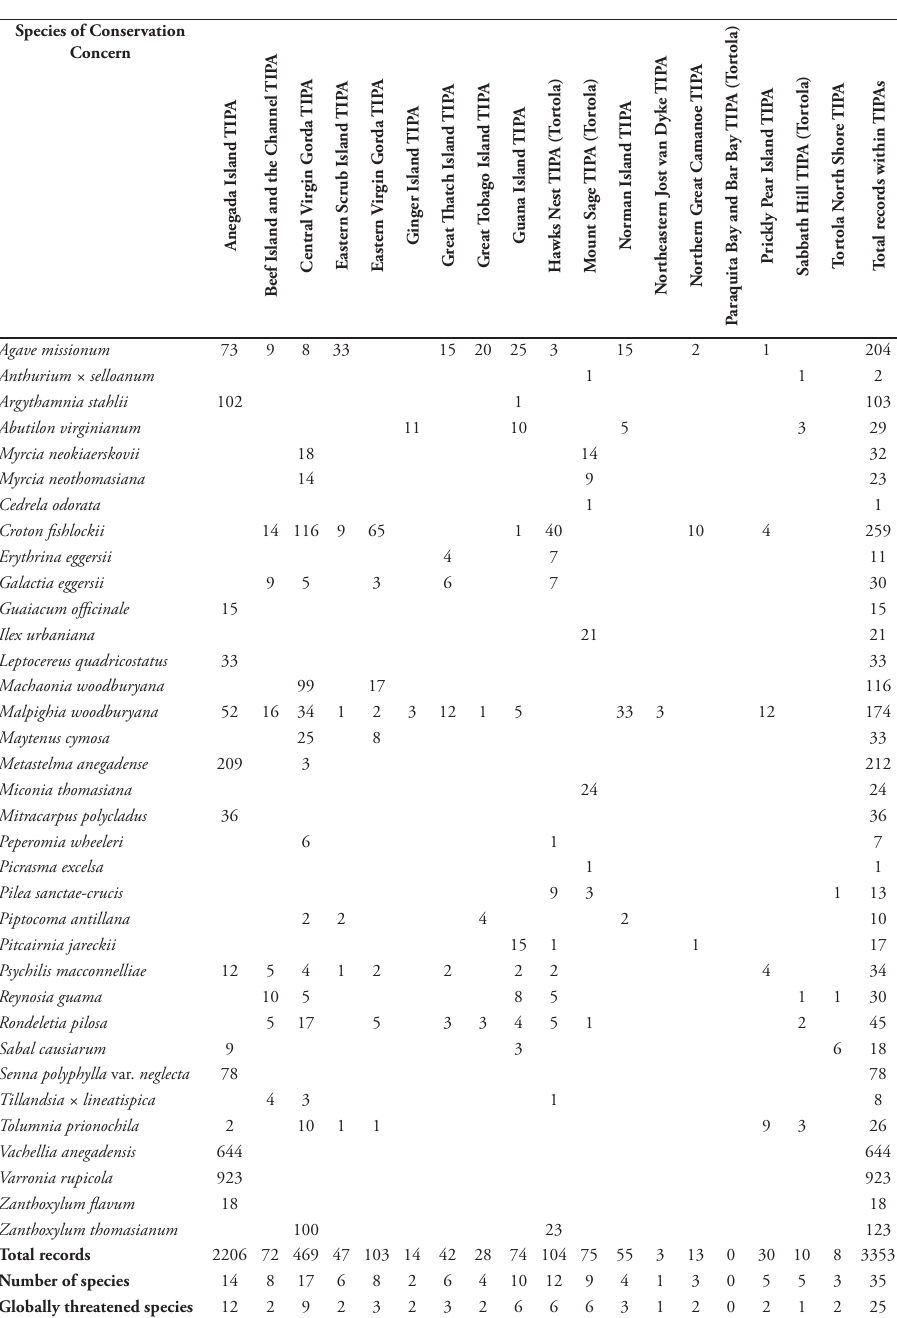
Table 2. TIPAs Network and occurrence of Species of Conservation Concern in the British Virgin Is- lands. Location of TIPA in () if not contained in the TIPA name. Abbreviations: Tropical Important Plant Area site